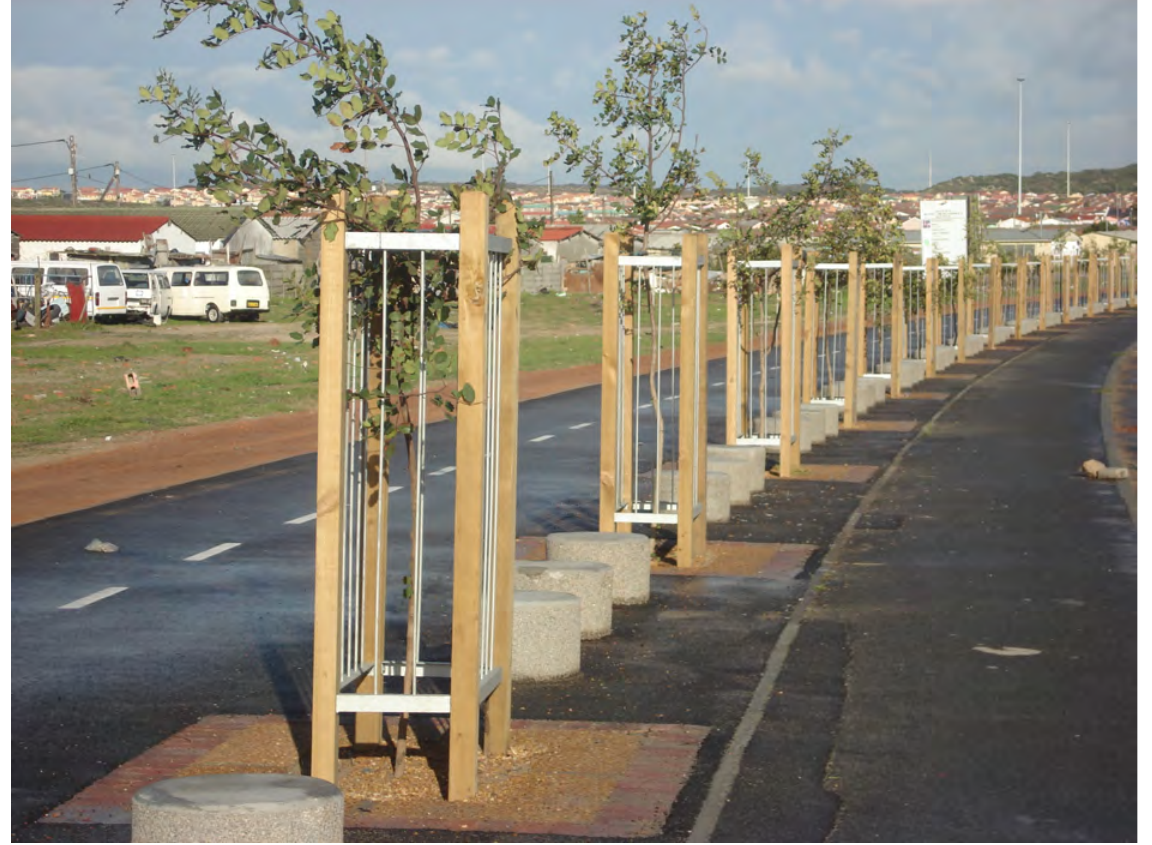
Figure 1: NMT project combining paving and tree planting in Khayelitsha